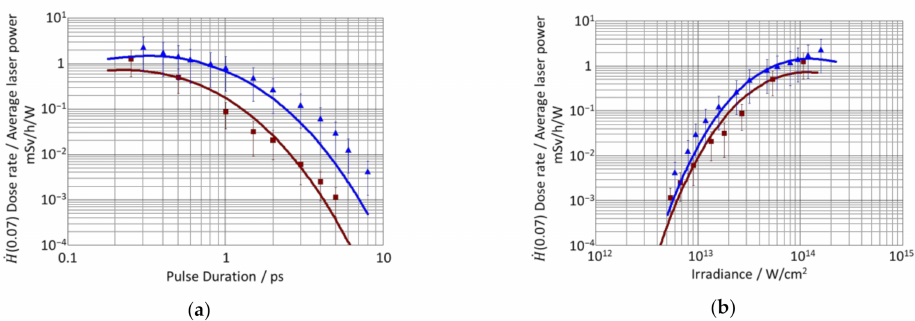
. H (0.07) dose rates divided by the average laser power as a function of the Figure 2. Measured pulse duration ( a ) and as a function of the irradiance ( b ) for constant average laser powers of 14 W (red squares) and 18.8 W (blue triangles) at a distance of 20 cm from the plasma. The solid lines were calculated with the extended model given in Equation (9) using the values of the respective experimental